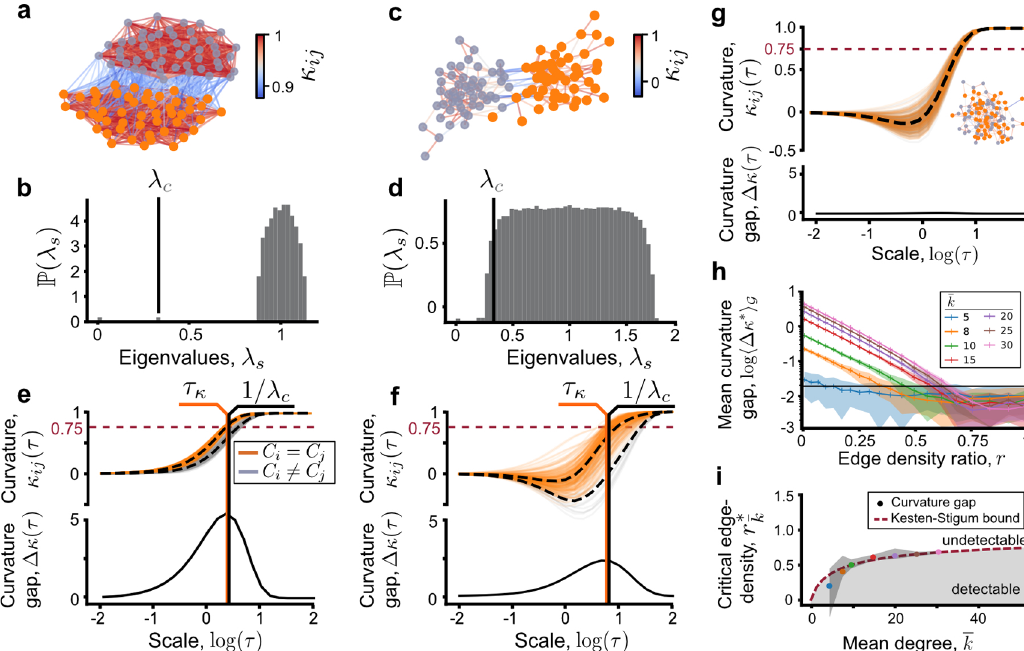
Fig. 2 Edge curvature gap indicates the presence of clusters where spectral clustering fails. Two-partition symmetric SBM graph in the a dense regime ( p in = 0.5, p out = 0.1) and b sparse regime ( p in = 8/ n , p out = 0.5/ n ). Edges are coloured by the curvature ( n = 100, log τ ¼ 0 : 83). c , d The histogram of eigenvalues obtained from fi ve SBM realisations in dense and sparse regime, respectively. In the dense regime, the eigenvalue λ c corresponding to the community structure is well separated from the bulk eigenvalues, but overlaps in the sparse regime. e , f The evolution of edge curvatures driven against diffusion time. A gap between the curvatures of within-edges (orange) and between-edges (grey) is associated with the presence of clusters. When κ ij > 0.75 (horizontal dashed line) the diffusions are well mixed across the respective edges. The curvature gap is maximal at τ κ (cid:4) λ (cid:2) 1 (orange and black vertical c lines). g There is no curvature gap in the limiting ER graph (inset, p in = p out = (8 + 0.5)/(2 n )). h Maximal curvature gap averaged over 20 SBM realisations for each fi xed (cid:2) k with 10 4 nodes, against edge density ratio. The horizontal line marks the estimated background noise level. The intersection of this line with the mean curvature gap de fi nes r (cid:3) (cid:2) , the largest possible edge density ratio to detect clusters. Shaded error bars indicate one standard deviation from the k mean. i Phase diagram of critical edge density ratio against average degree. The numerically obtained critical edge density ratios computed from the curvature gap are superimposed with the theoretical Kesten – Stigum detection limit (dashed line) and show excellent agreement. Shaded error bars indicate one standard deviation from the mean. Grey shaded area denotes the regime where detection is